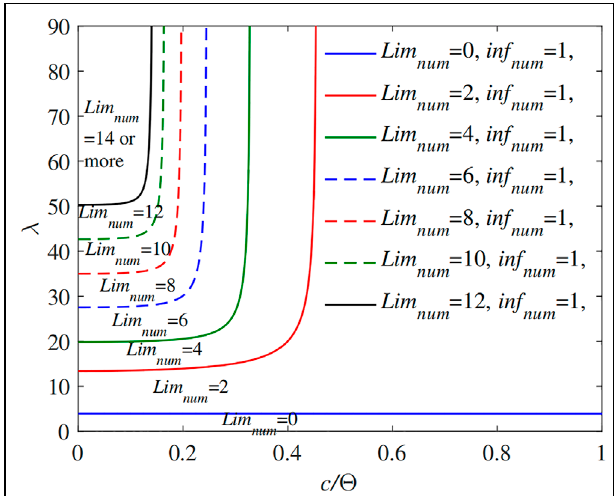
FIGURE 8 | The number of multiple limit points of limit point instability for pin-ended FGM